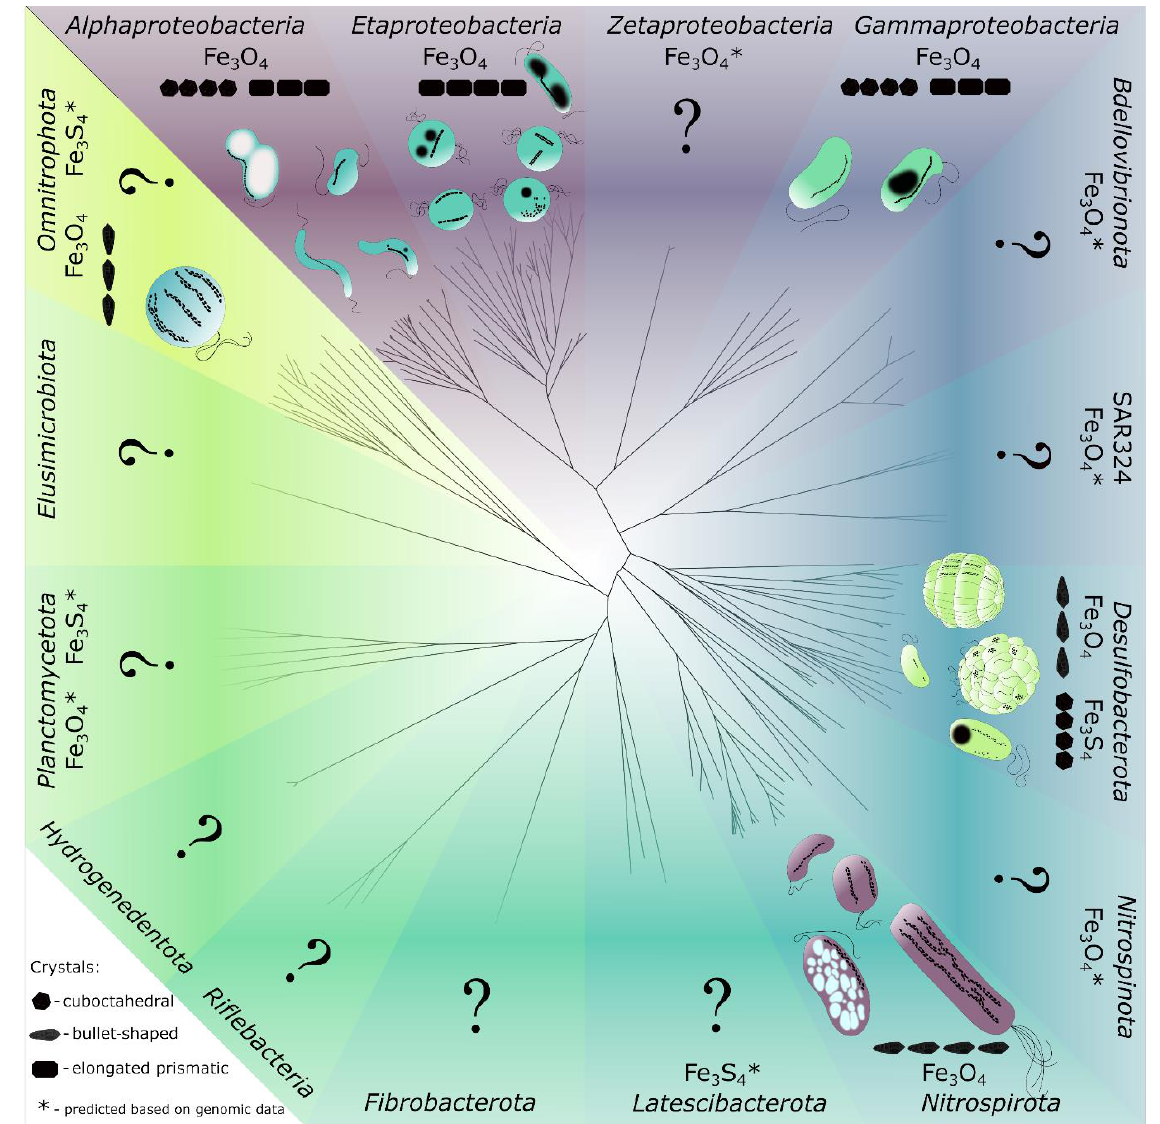
Figure 2. Phylogenetic distribution of MTB. The maximum likelihood phylogenomic tree was inferred from the concate- nation of 120 single copy marker proteins using LG + F + I + G4 model. The analysis was performed on 264 genomes of cultured and uncultured MTB. Question marks indicate a lack of data on cell morphology and/or the shape and composition of magnetosome crystals.